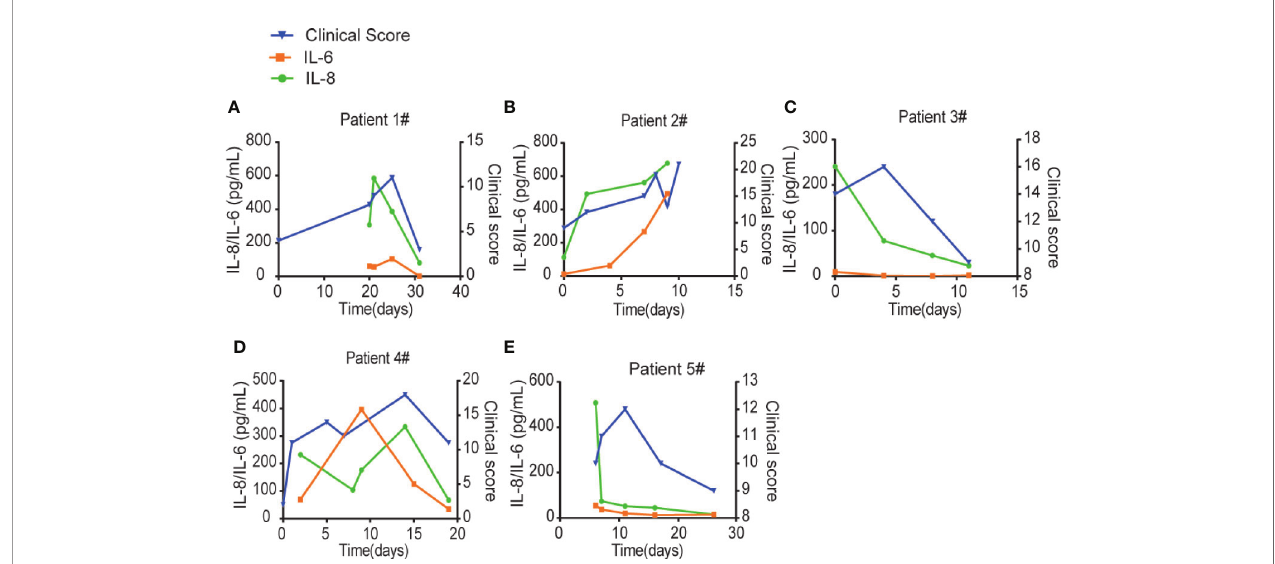
FIGURE 5 | IL-8 may serve as a biomarker to indicate the COVID-19 disease prognosis. (A – E) IL-6 and IL-8 levels were compared with different patients ’ clinical scores at multiple time points. Left Y-axis displays the concentration of cytokines: IL-6 in orange and IL-8 in green. Right Y-axis displays the clinical scores depicted in blue. X-axis displays the day numbers of COVID-19 diagnosis from the fi rst positive PCR